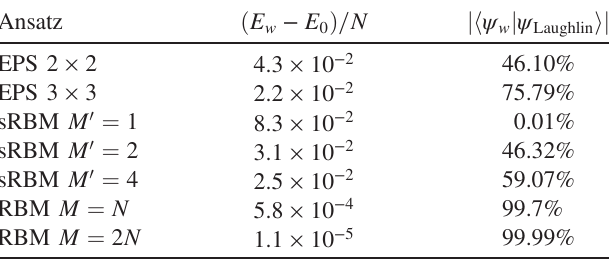
TABLE I. Energy per site difference with the ground-state energy and overlap with the Laughlin state of different Ansatz wave functions optimized with respect to the Hamiltonian H on a 6 × 6 square lattice with open boundary conditions. Note that sRBM have M 0 hidden units connected to all spins in each plaquette of size 3 × 3 , while RBM have M hidden units connected to all spins of the